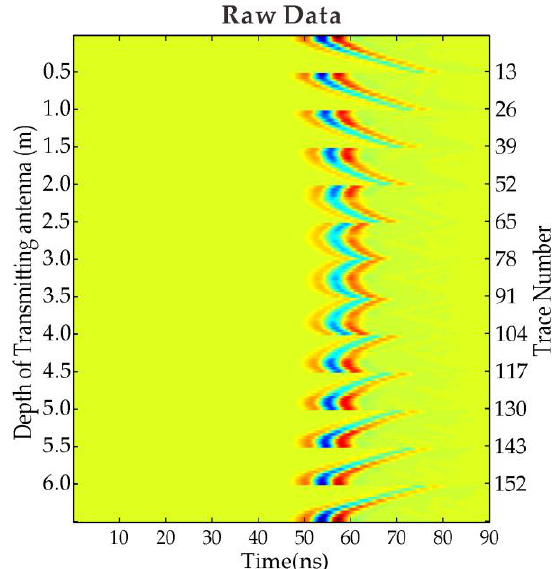
Figure 5. Raw data of complex synthetic model with three pipeline anomalies buried in the layered medium.